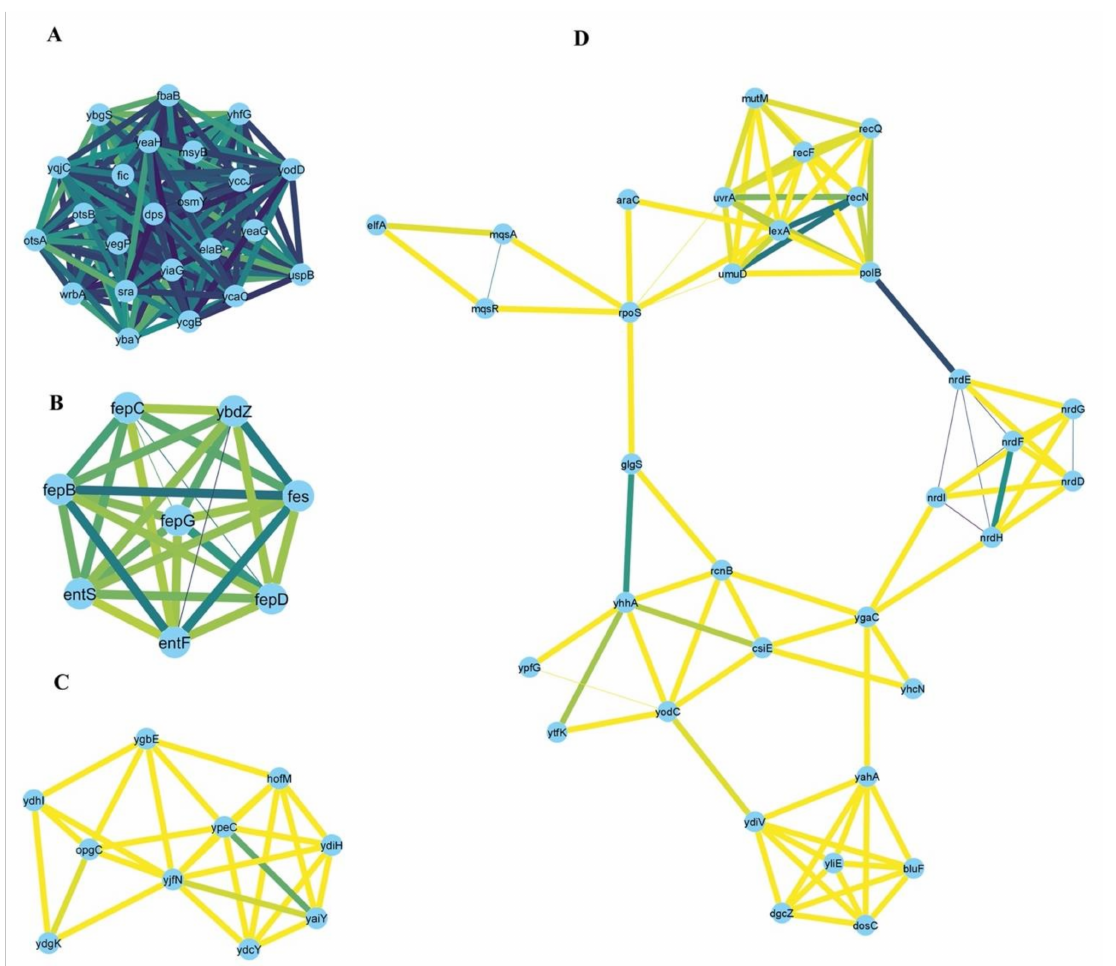
Figure 6. Four main sub-clusters (numbered A – D ) were identified by the MCODE clustering algo- rithm from the network of the upregulated genes in at least three stressors. Examples of the hub genes are mentioned in the Discussion